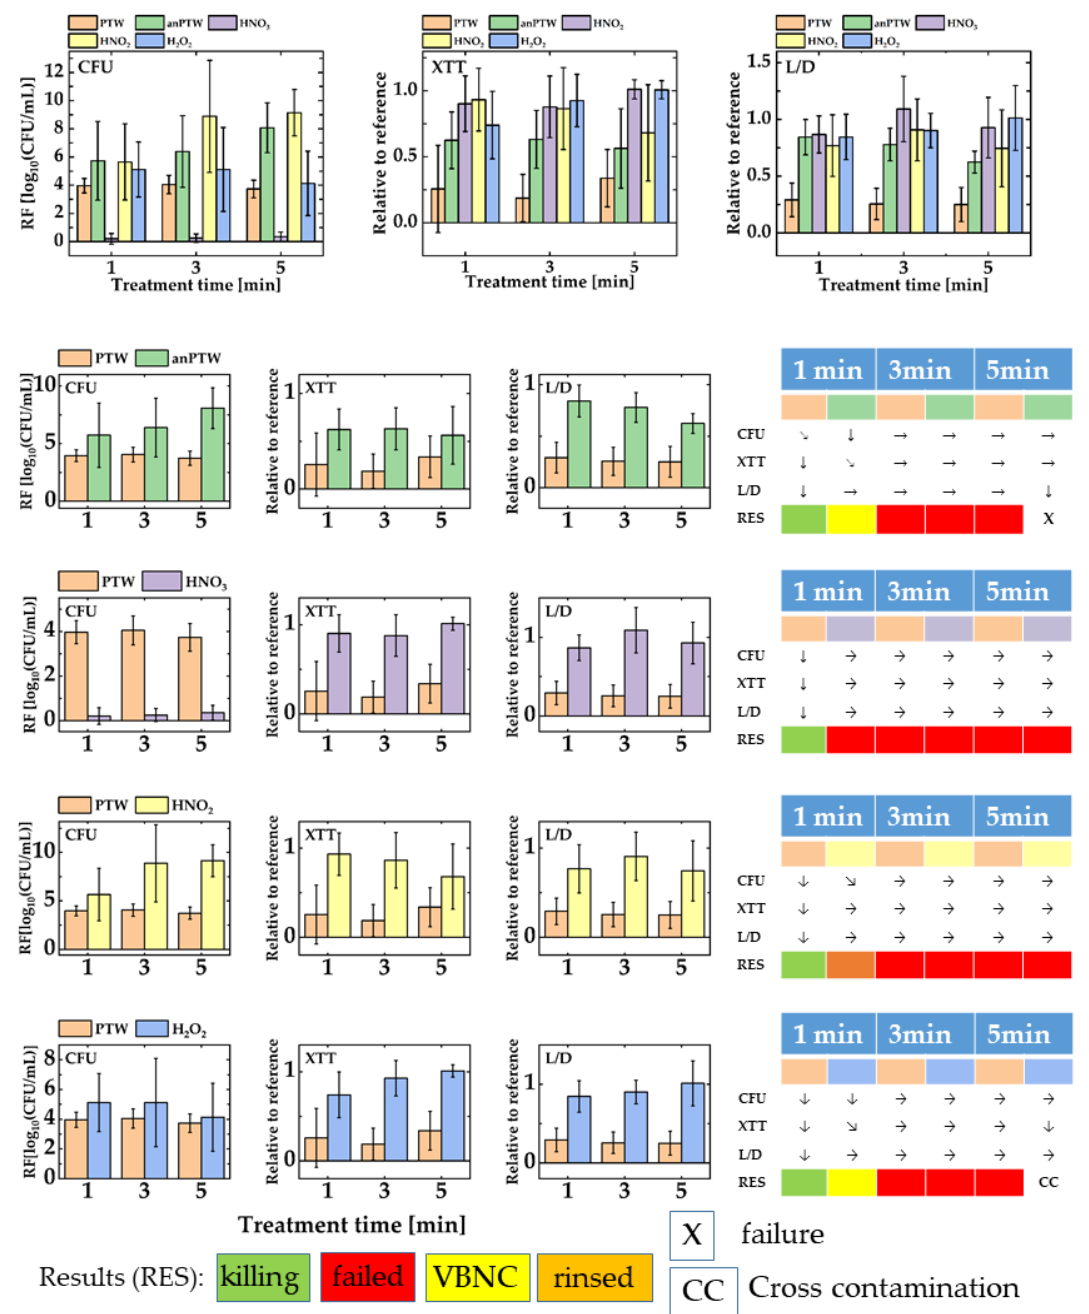
Figure 4. A summary of all assay data (CFU, XTT, and L/D) for bio fi lms of Pseudomonas fl